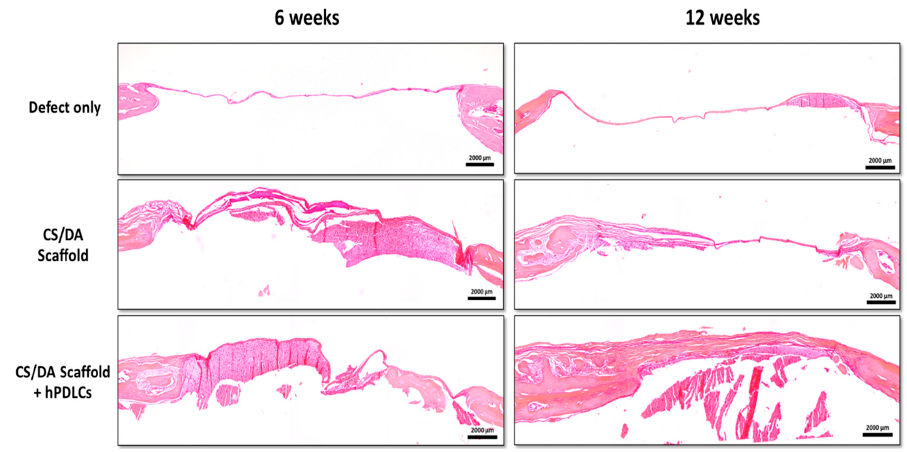
Figure 4. E ff ect of CS / DA sca ff old on bone regeneration in mouse calvarial defects as assessed by H&E Figure 4. Effect of CS/DA scaffold on bone regeneration in mouse calvarial defects as assessed by H&E staining (magnification ×2) . staining (magnification × 2)